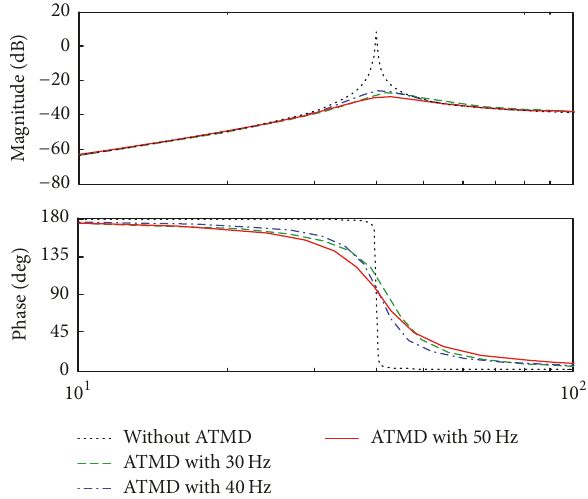
Figure 4: Vibration attenuation in the ATMDs with different fre- quencies.